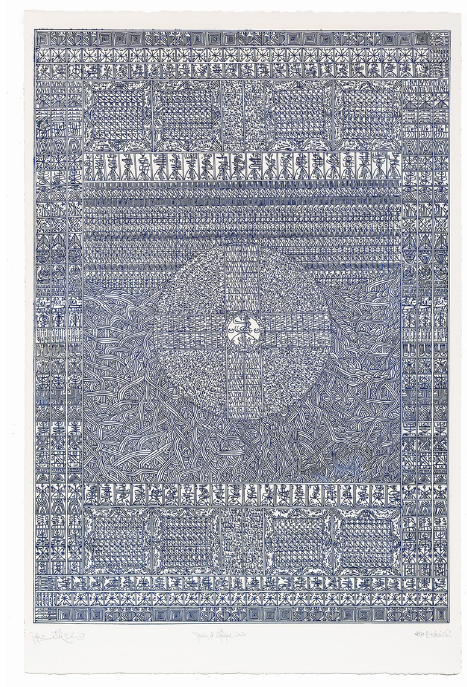
Figure 16. Rachid Koraïchi, The Garden of Africa—Le Jardin d’Afrique . 2020. Edition of 70, Etching, 108.5 × 76 cm (RK5039). © Rachid Koraïchi.